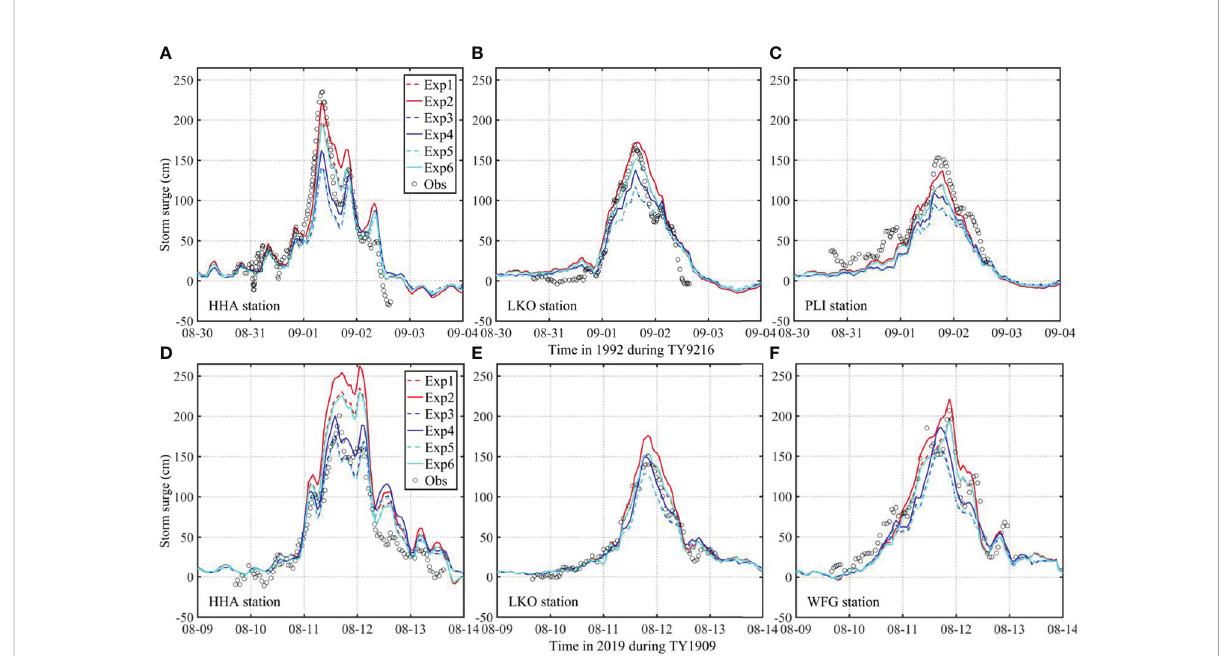
FIGURE 5 Storm surge veri fi cation at the tide gauge stations, including HHA station (A) , LKO station (B) and PLI station (C) during TY9216, and HHA station (D) , LKO station (E) and WFG station (F) during